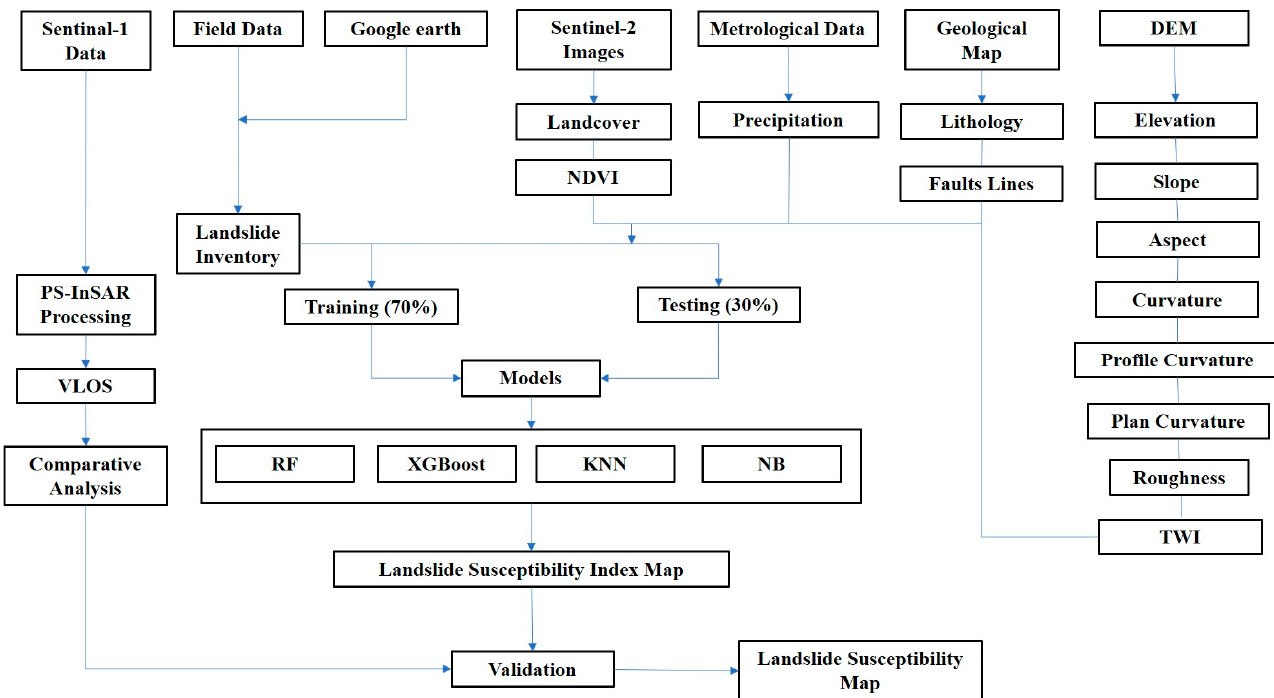
Figure 3 . Flow chart of research. Figure 3. Flow chart of